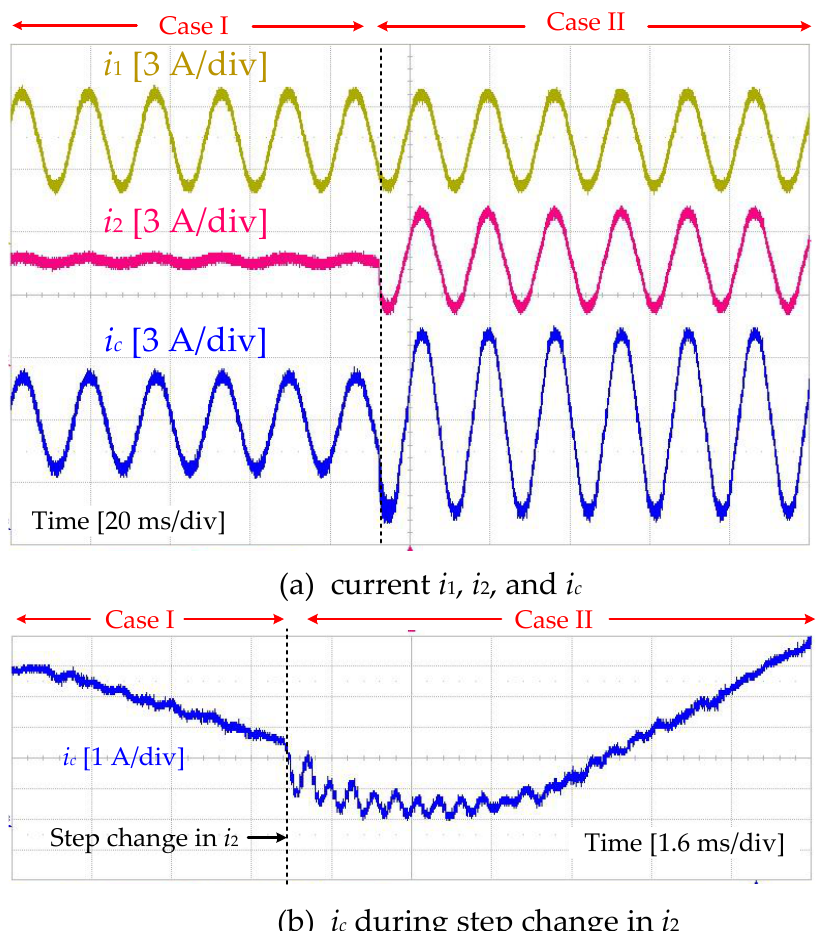
Figure 11. Experimental results for Cases I and II under the conventional scheme presented in [7].